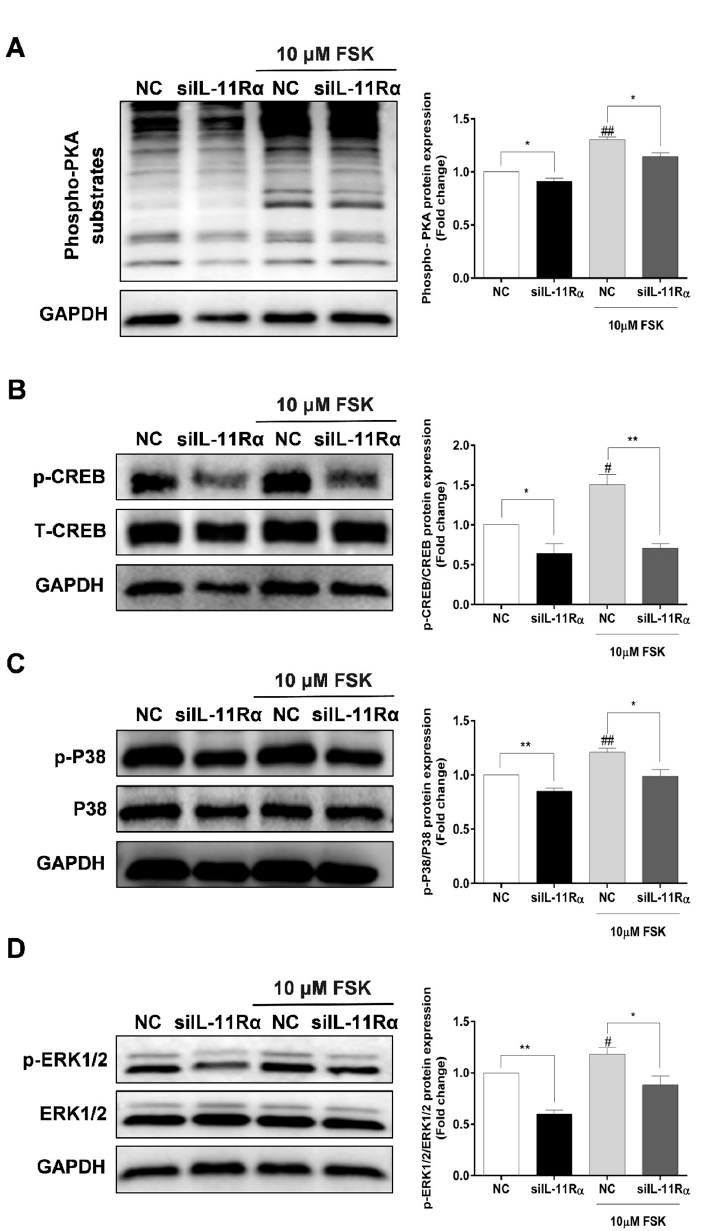
Figure 7. Effect of IL-11R α knockdown on the phosphorylation of PKA substrates, CREB, p38MAPK, and ERK1/2. ( A ) After 48 h of siIL-11R α transfection, the protein levels of phospho-PKA substrates were examined by Western blot, the quantitative results indicated fold change in the phospho- PKA/GAPDH ratio compared to the negative control. ( B ) After 48 h of siIL-11R α transfection, the quantitative results indicated fold change in the phospho-CREB/CREB ratio compared to the negative control. ( C ) After 48 h of siIL-11R α transfection, the quantitative results indicated fold change in the phospho-p38MAPK/p38MAPK ratio compared to the negative control. ( D ) After 48 h of siIL-11R α transfection, the quantitative results indicated fold change in the phospho-ERK/ERK ratio compared to the negative control. The representative Western blots from three independent experiments are shown. * p < 0.05 and ** p < 0.01 between the indicated groups. # p < 0.05 and ## p < 0.01 between the negative control (-FSK) and the FSK treatment-alone